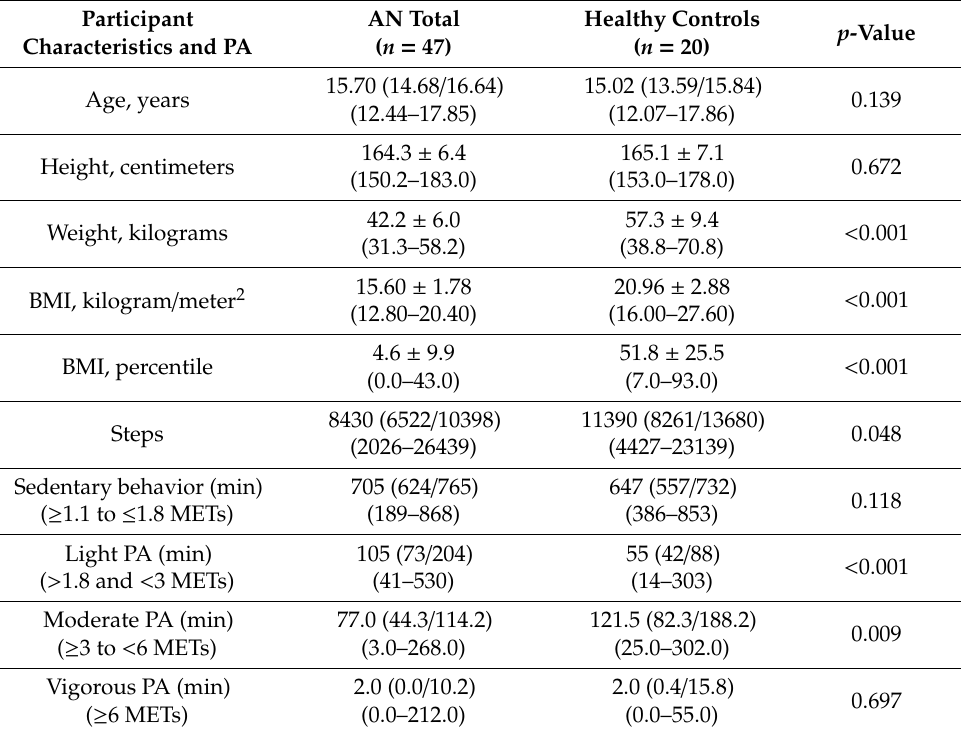
Table 1. General characteristics and physical activity parameters of patients with AN at first study assessment compared to healthy